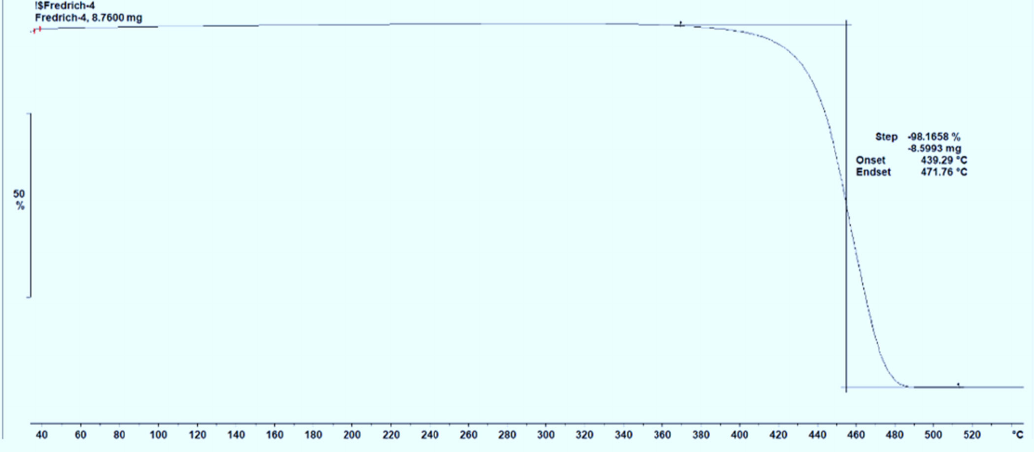
Figure A4. TGA curve after the 5th print cycle.